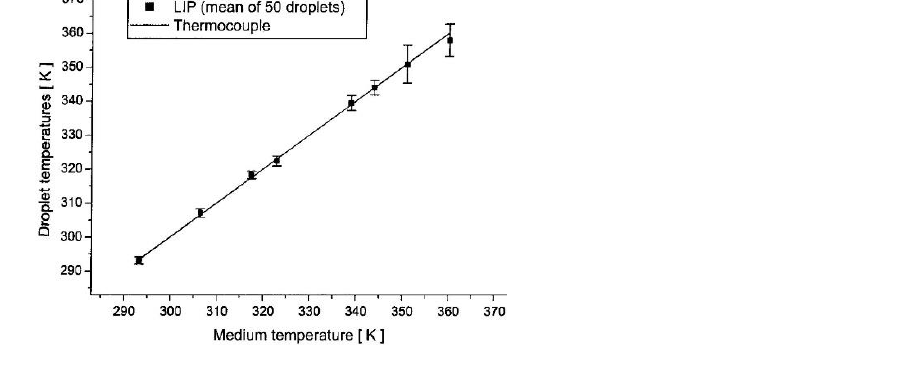
Figure 18. Average value of 50 droplet temperature measurements by lifetime method at different temperatures and the results from thermocouple [130]. Reprinted with permission from [130]. Optica Publishing Group, 2004.